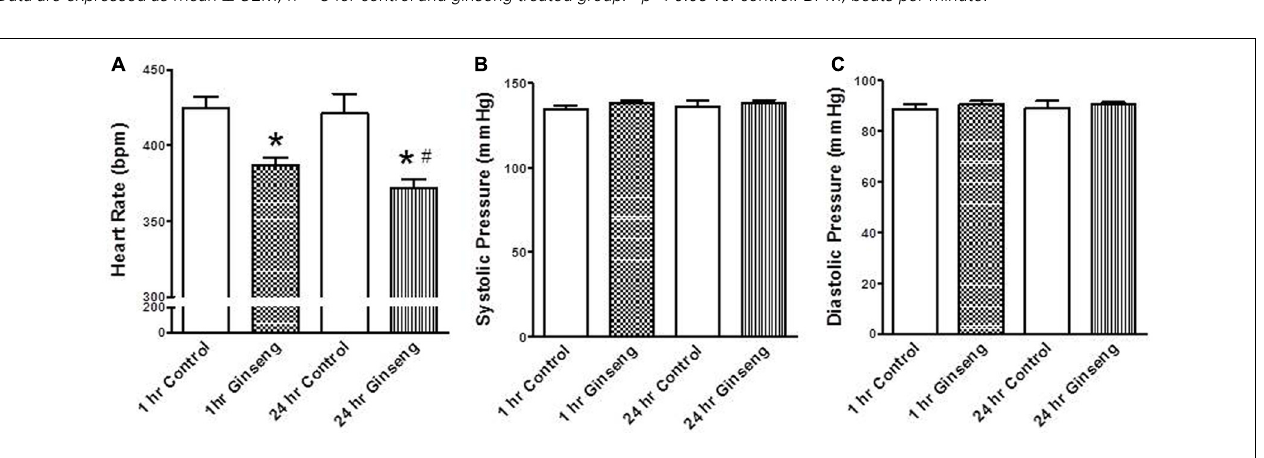
(B,C) Display systolic and diastolic blood pressure, respectively. Data are presented as mean ± SE. * p < 0.05 compared to control; # p < 0.05 compared to 1 h ginseng